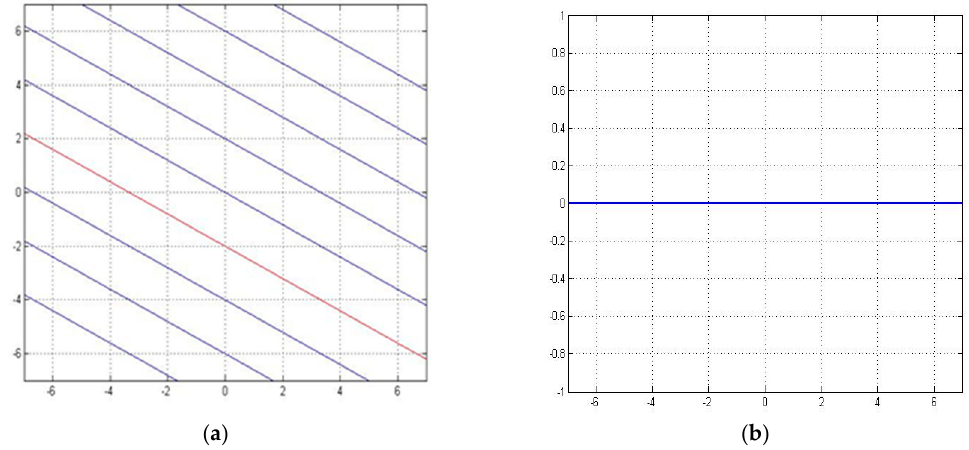
Figure 8. The performance of interpolation and extrapolation for a uniform parallel flow. ( a ) Particle paths obtained by our method, ( b ) The error curve. Case 2.